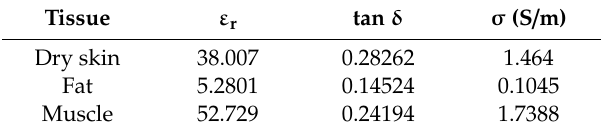
Table 2. Dielectric properties of human tissues at 2.45 GHz [45].